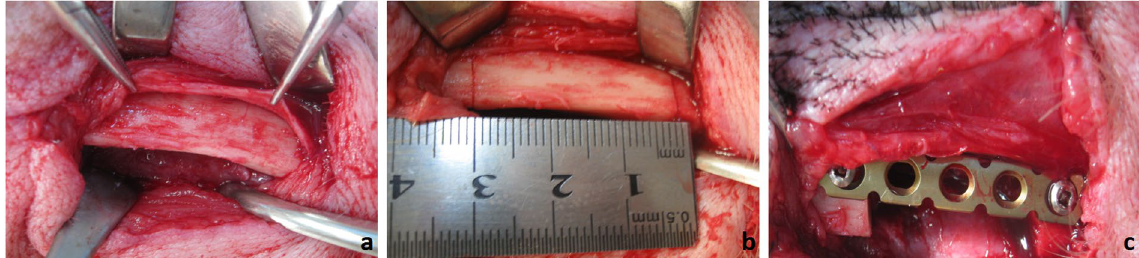
Figure 1. The surgical procedure. ( a ) The intact periosteum was bluntly and carefully detached from the cortical surface to expose the mandible. ( b , c ) 3-cm segmental mandible was resected with periosteum preserved, and a reconstruction plate was fixed across the